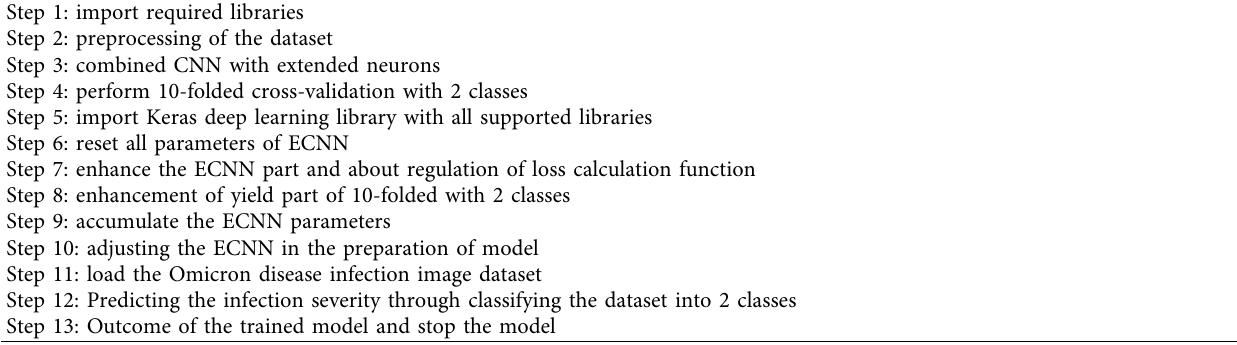
Table 3: Algorithm steps of the ECNN approach.